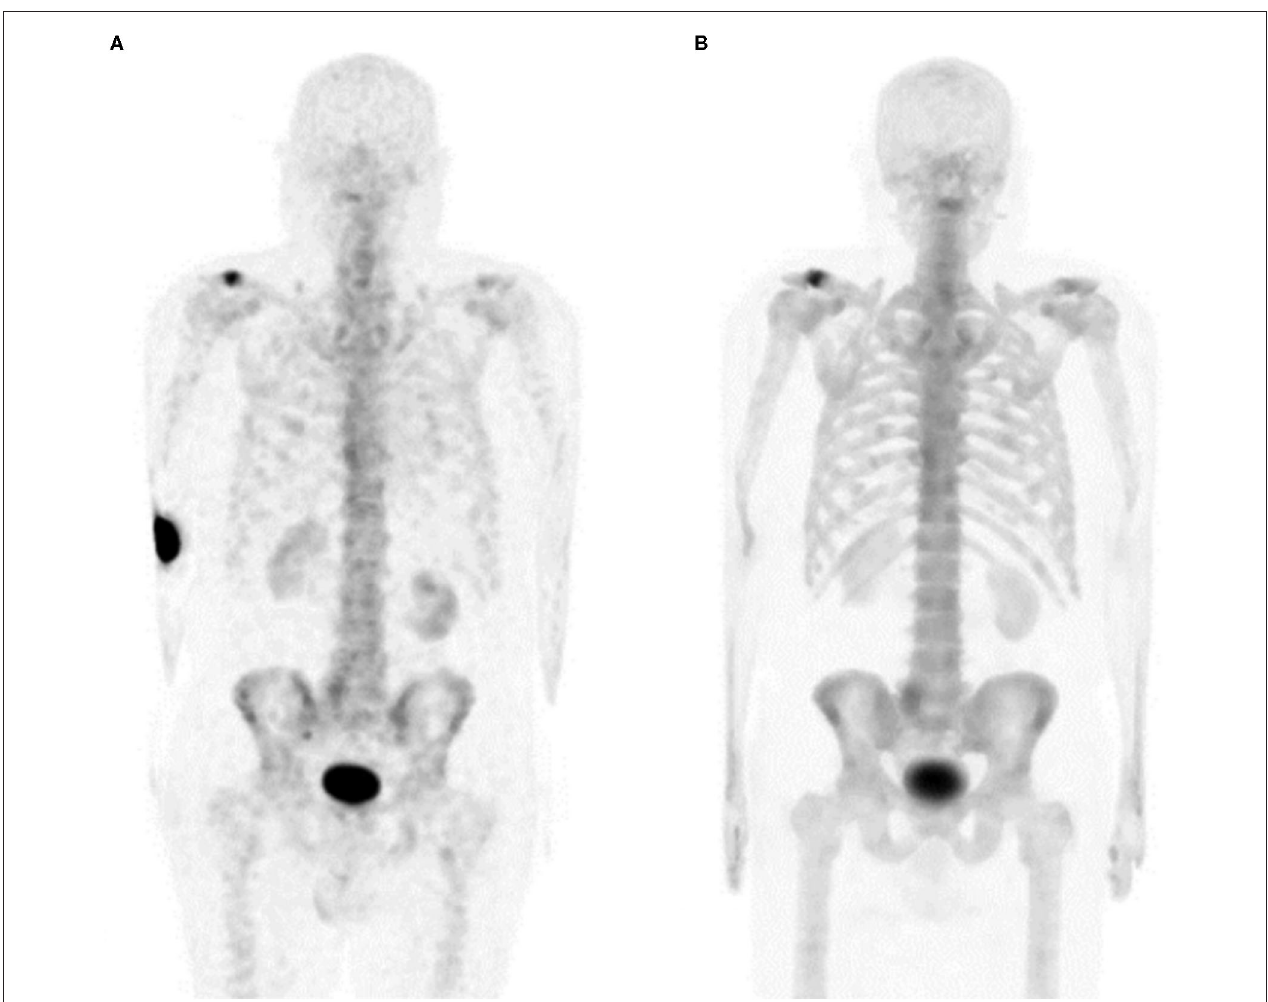
FIGURE 3 | Patient C MIP images. (A) Extravasated injection. (B) Repeated imaging. Extravasations of diagnostic